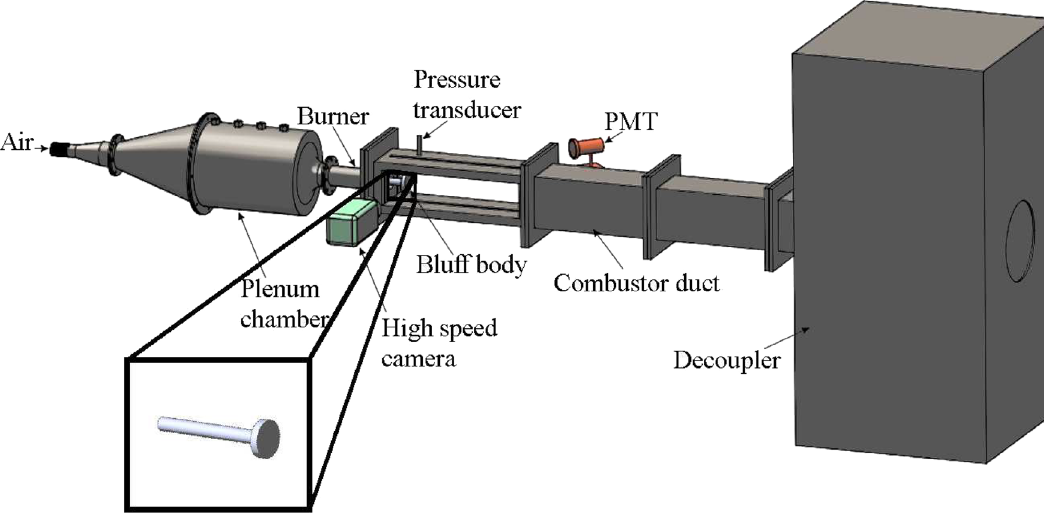
Figure 7. Schematic of the bluff-body stabilized turbulent thermoacoustic system. The experimental setup is a turbulent combustor that consists mainly of a plenum chamber, a burner and a combustion chamber. We utilize a piezoelectric pressure transducer, a photomultiplier tube and a high-speed camera to record data simultaneously. The inset shows a zoomed version of the